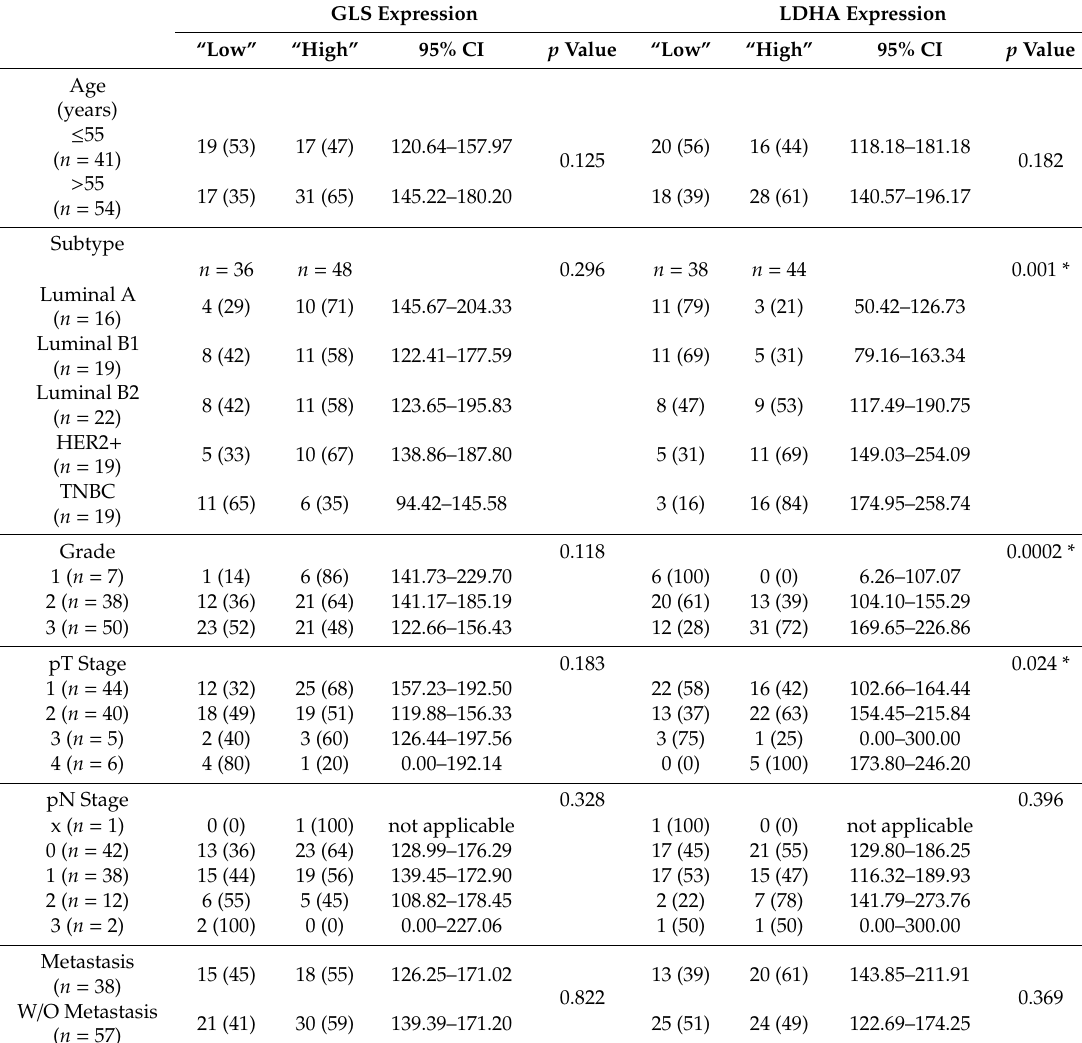
Table 2. Correlation of clinicopathological parameters of breast cancer patients with GLS and LDHA expression (determined by IHC). * p <